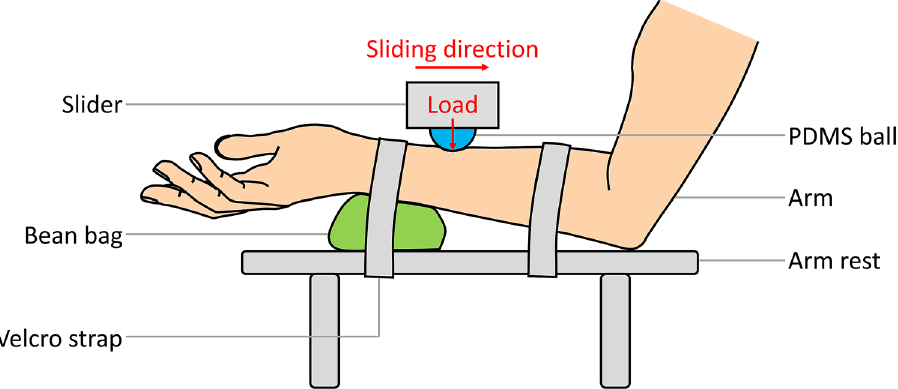
Figure 1. Schematic of the in-vivo tribometer setup (the image was created by Microsoft PowerPoint 2016).